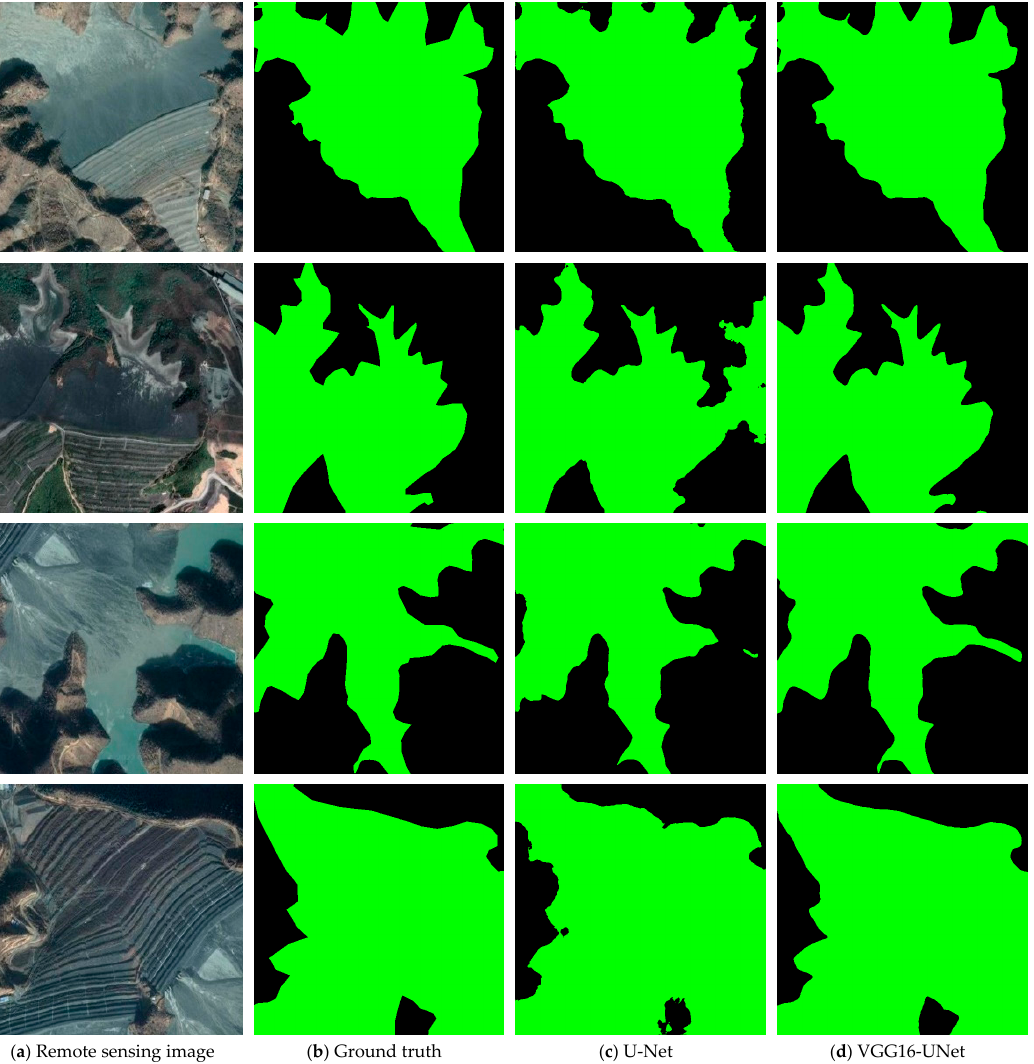
Figure 12. Comparison of the visual results of the two models on the test set. The remote sensing image, ground truth, U-Net prediction results, and VGG16-UNet prediction results of tailings ponds are shown in order from left to right.